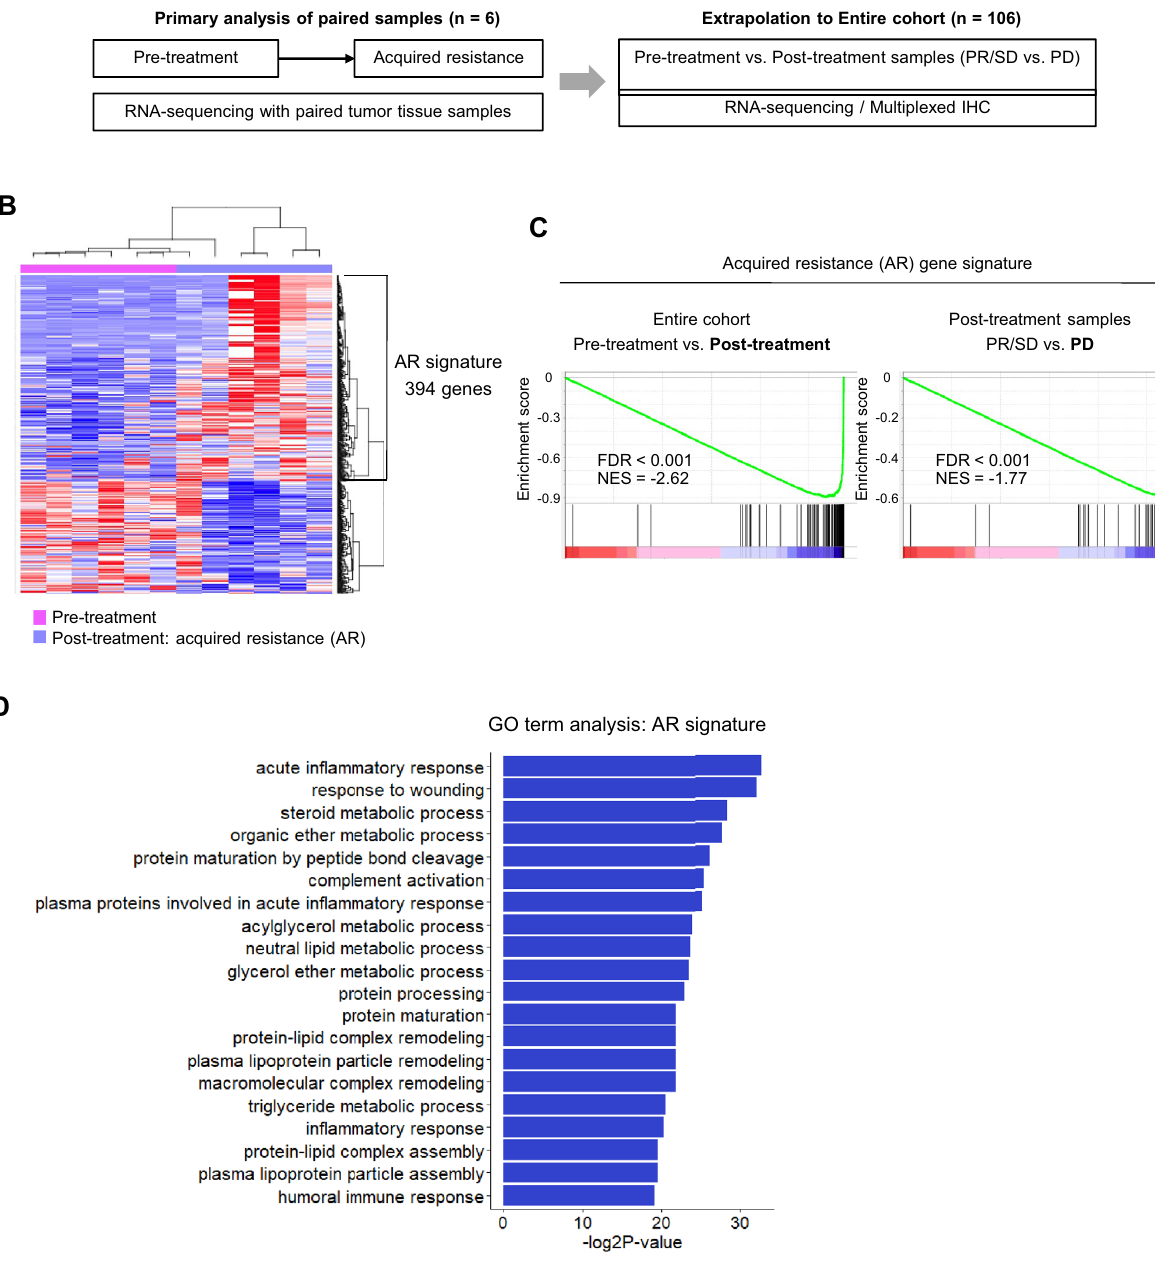
Figure 1. Gene signature of acquired resistance. ( A ) Overall scheme of the study. ( B ) Heatmap of differentially expressed genes between pre-treatment and post-treatment tumor samples in patients who develop acquired resistance (AR) (n = 6 pairs). ( C ) Gene Set Enrichment Analysis of the AR signature in the entire cohort and post-treatment samples. ( D ) Gene ontology pathway analysis of the AR